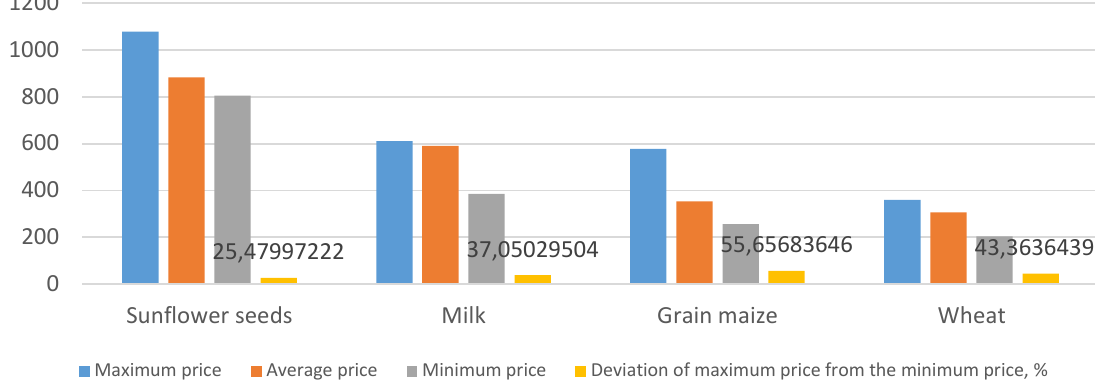
Figure 1. Difference in the sale prices for core products of agricultural enterprises of Khrystynivka district (2016